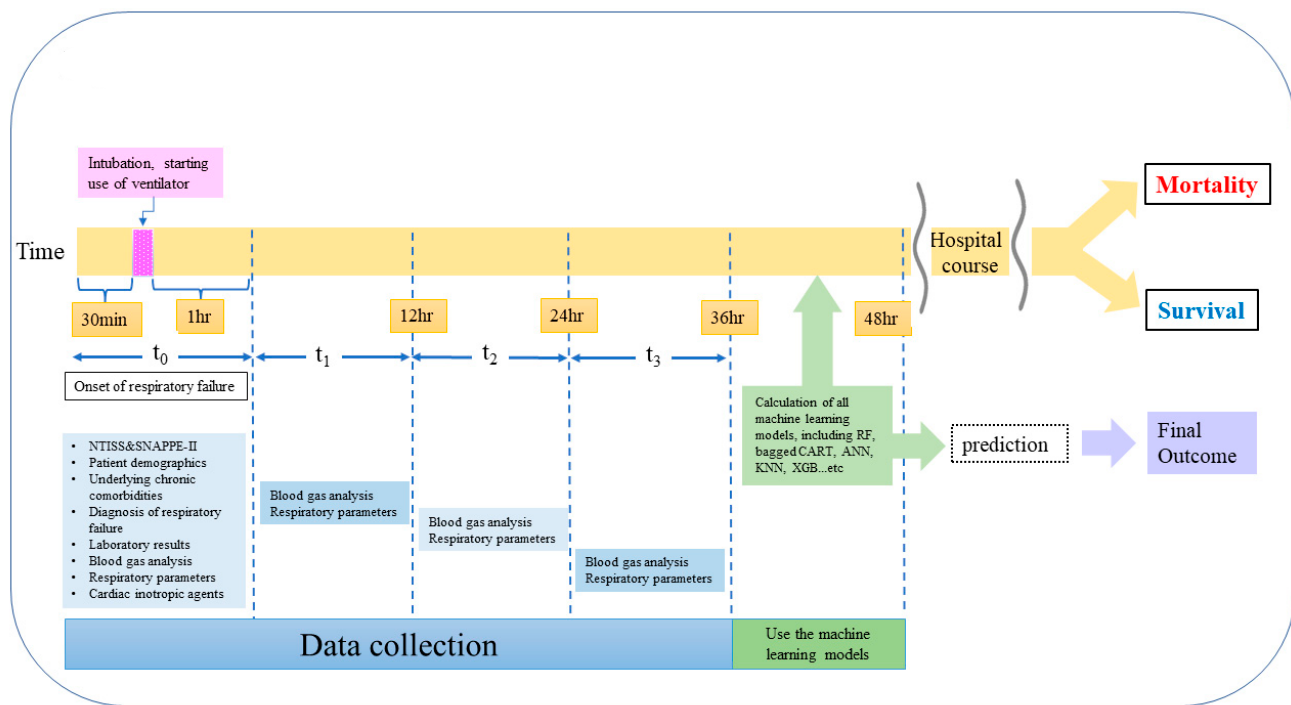
Figure 1. Time period and time point to collect the whole features and variables of the training and test sets. The study design highlights that the clinically applicable machine model can be used on the second day of respiratory failure to predict the in-hospital mortality of neonates with respiratory failure.